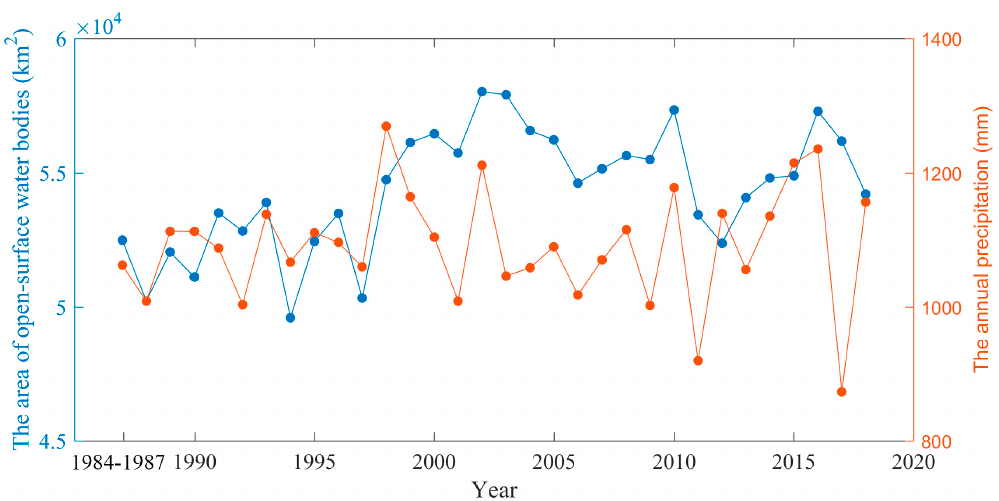
Figure 12. The time series of maximum water bodies and annual precipitation in the YRB from 1984 to 2018. Table 4. The trend and correlation in maximum water bodies and precipitation in the YRB. Period Maximum water bodies Precipitation Correlation